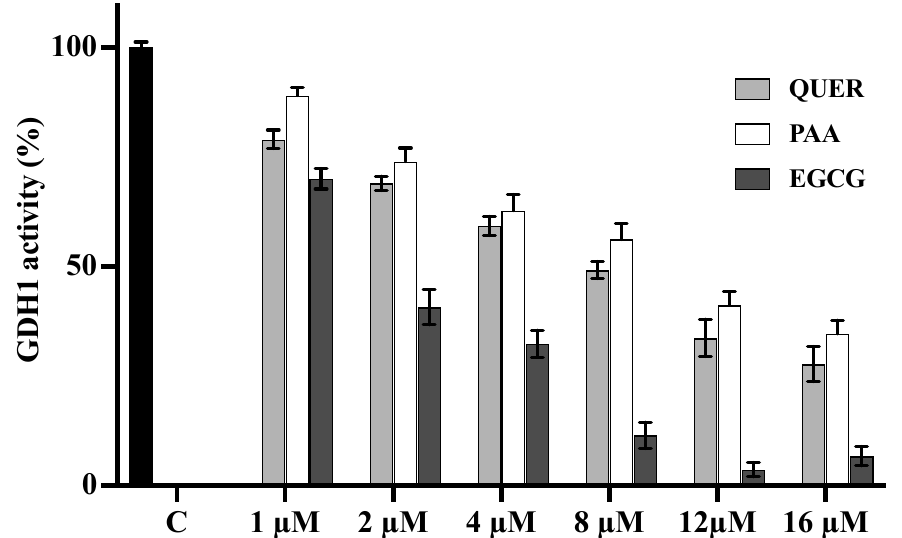
Figure 4. Effect of Quercetin, PAA, and EGCG on the activity of purified bovine liver GDH1. The activity of purified bovine liver GDH1 was initiated by adding NH 4 Cl in the absence (black column) or in the presence of increasing external concentrations of Quercetin (light grey columns), PAA (white columns) or EGCG (grey columns). The residual activities (%) in presence of quercetin, PAA or EGCG are the means ± SD of at least three independent experiments. Differences between samples are significant ( p < 0.05, one-way ANOVA).